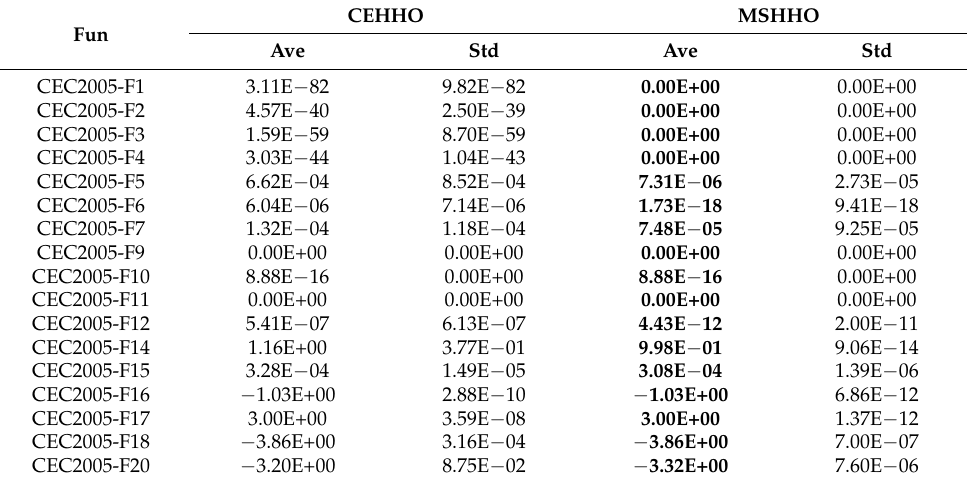
Table 7. Comparison of the results of different improved